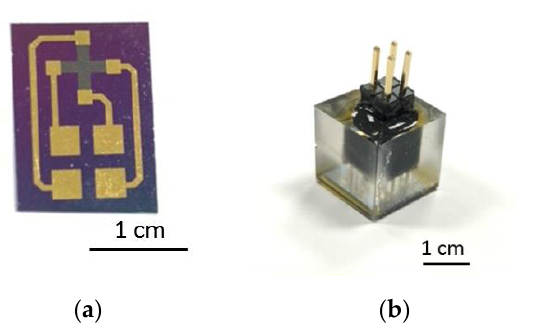
Figure 5. Photographs of: ( a ) complete Hall sensor, and ( b ) resin-encapsulation of individual Hall sensor.